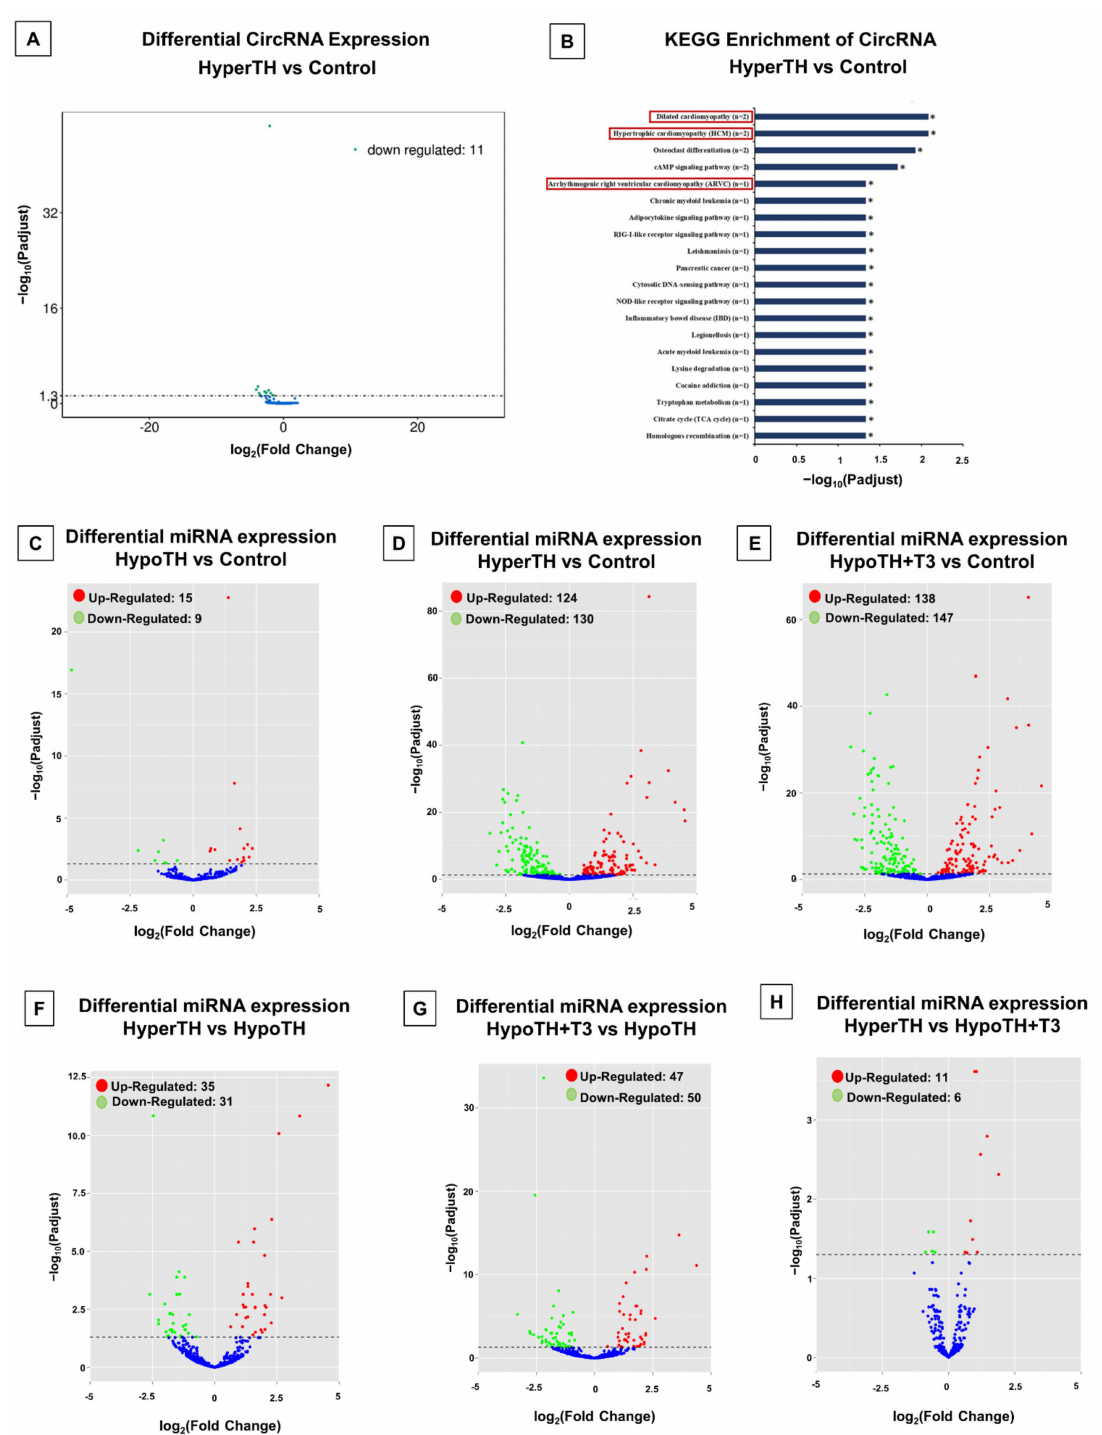
Figure 5. Differential Expression Analyses of CircRNAs and miRNAs. ( A ) Comparison of HyperTH (Hy- perthyroid) and Control groups revealed 11 CircRNAs, which were significantly differentially expressed. ( B ) KEGG enrichment analysis of top 20 pathways with significantly altered circRNA targets between HyperTH and Controls. Statistically significant KEGG enrichments are marked with asterisks. Cardiac disease-related pathways are highlighted in red boxes. ( C – H ) Differential expression analysis of miRNAs in ( C ) HypoTH vs. Control ( D ) HyperTH vs. Control ( E ) HypoTH + T3 vs. Control ( F ) HyperTH vs. HypoTH ( G ) HypoTH + T3 vs. HypoTH and ( H ) HyperTH vs. HypoTH + T3 groups. For all analyses, the targets were considered statistically significant with p -adj(corr) <